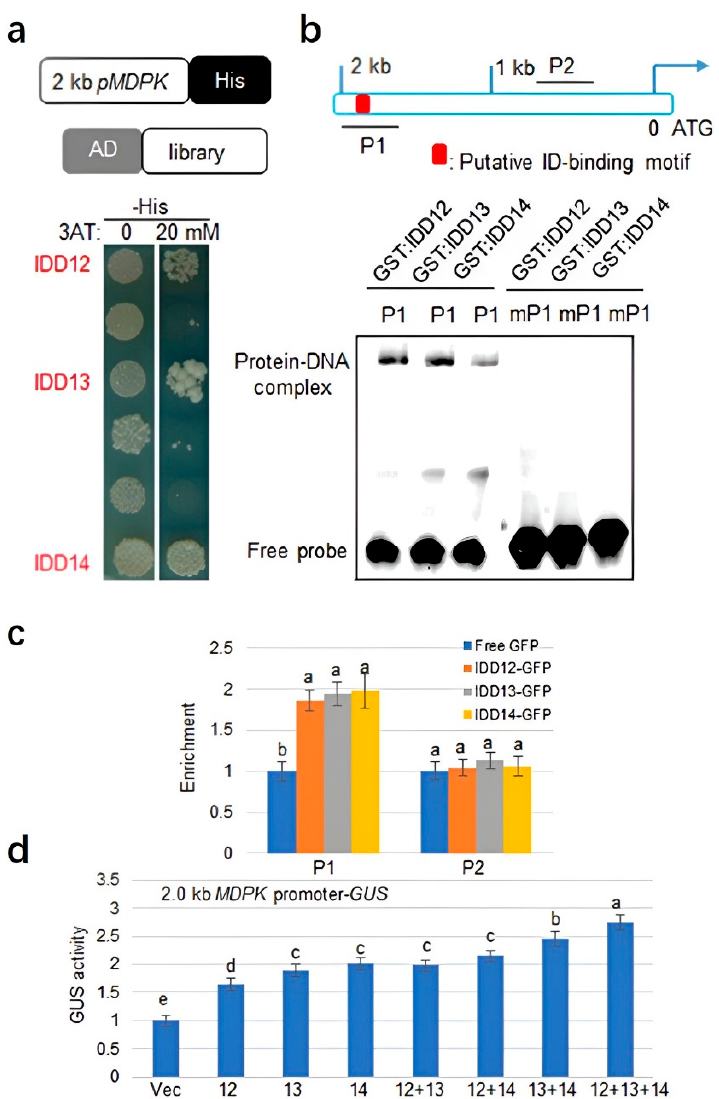
Figure 2. The regulation of IDD12, IDD13 , and IDD14 to MDPK transcription: ( a ) yeast one-hybrid assay revealed that IDD12, IDD13, and IDD14 can bind to the promoter of MDPK . The upper schematic indicates the 2 kb of MDPK promoter and rice cDNA library used for the yeast-one hybrid analysis. The transformants were grown on the SD media with or without 20 mM of 3-amino-1,2,4-triazole (3AT), a competitive inhibitor of HIS3; ( b ) EMSA assay showed that IDD12, IDD13, and IDD14 have specific affinity to the putative IDD-binding motif (red box) P1 within 2 kb of MDPK promoter. The mutant probe mP1 was used as control. The probe was labeled with biotin and bands were detected by using antibiotin antibodies; ( c ) ChIP-qPCR assays. Enrichment of IDD12, IDD13, and IDD14 at the promoter of MDPK was measured via ChIP-qPCR using anti-GFP antibodies. The schematic in ( b ) indicates the locations of the DNA fragments P1 and P2 used for